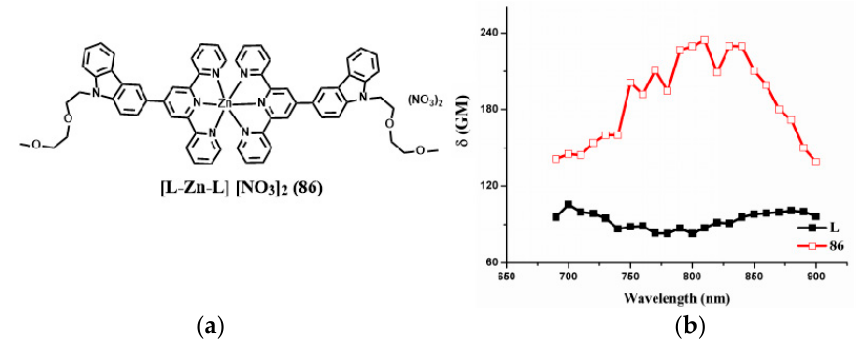
Figure 22. ( a ) Molecular structures of the ligand (L) and its metal complex ( 86 ); ( b ) 2PA spectra of L and related complex 86 .